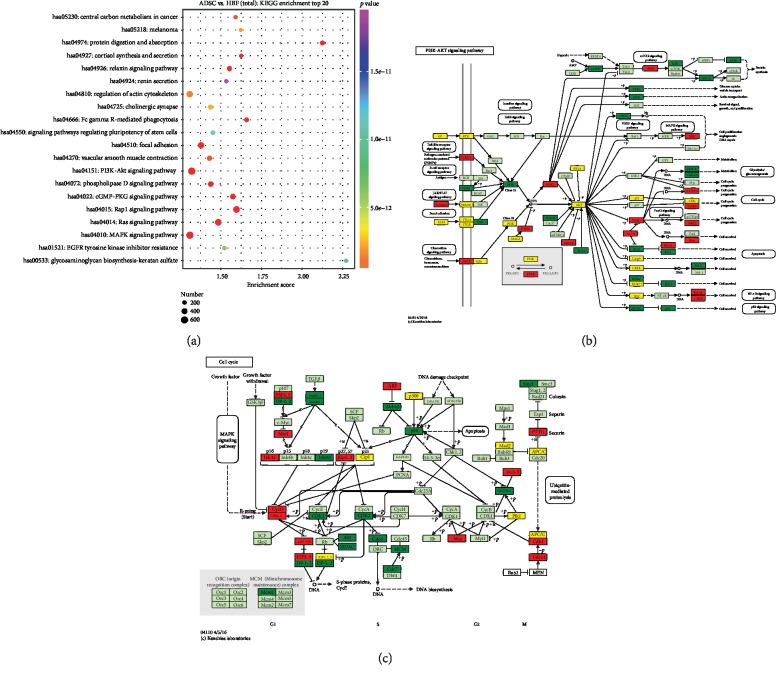
Target gene KEGG enrichment analysis. (a) The top 20 pathway enrichment analysis of differential expression genes by the KEGG database. Each dot in the figure corresponds to a pathway. The order of P value from small to large corresponds to red, orange, yellow, green, blue, indigo, and purple, respectively. In brief, the color tends to be red, the smaller the P value. In addition, the larger the dot, the more genes in the pathway. (b–c) The PI3K-Akt (b) and MAPK (c) pathway in the KEGG database. Red indicates upregulated genes, green indicates downregulated genes, and yellow indicates both upregulated and downregulated genes.